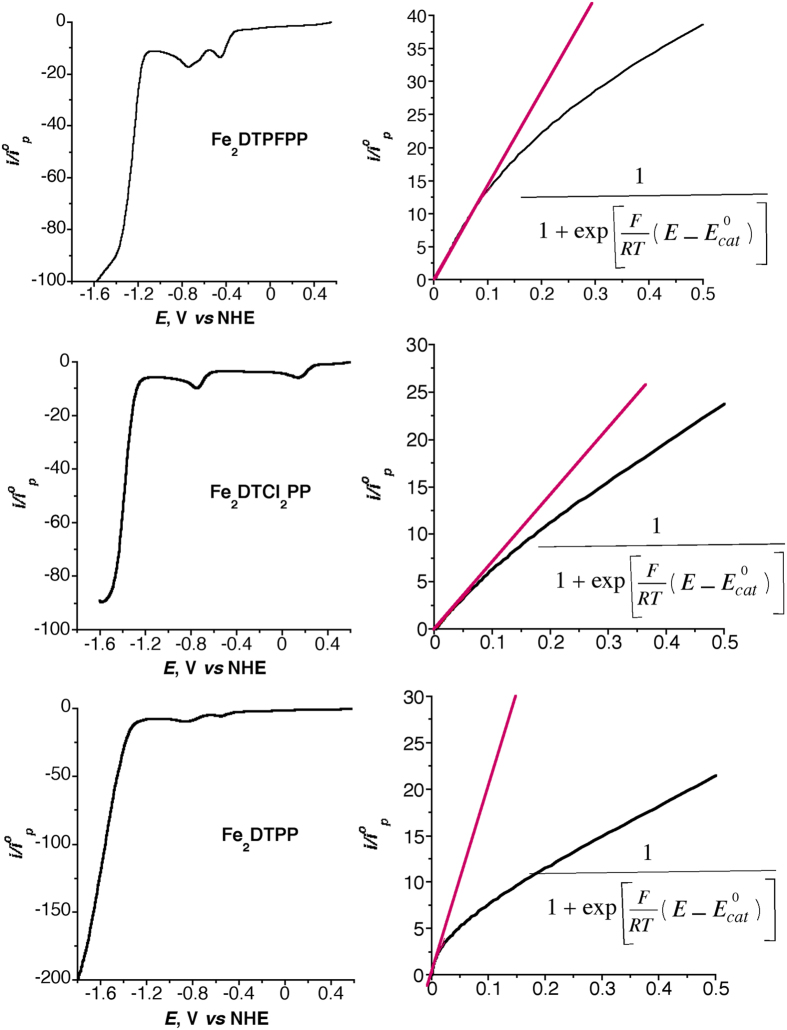
Catalytic CV responses (left, forward scan only shown for clarity) of three Fe porphyrin dimers (0.5 mM) at 100 mV/s scan rate in DMF/10% H2O saturated with CO2 and the corresponding foot-of-the-wave analysis (right).